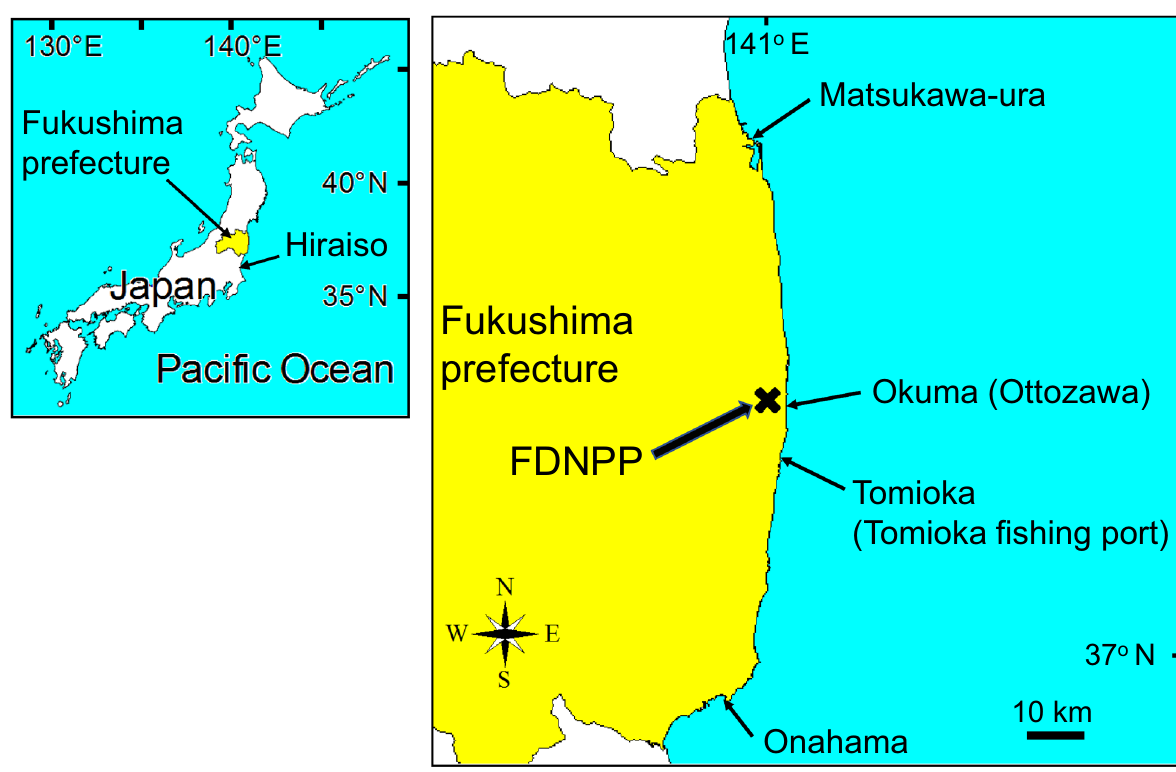
Figure 1. Sampling sites of the rock shell ( Thais clavigera and Thais bronni ) between April 2017 and May 2019. Two sites were near the Fukushima Daiichi Nuclear Power Plant (FDNPP) in Fukushima prefecture: Ottozawa, Okuma town, and Tomioka fishing port, Tomioka town are approximately 1 km and 10 km south of the FDNPP, respectively. The reference site, Hiraiso, Hitachi-naka city, Ibaraki prefecture, is approximately 120 km south of the FDNPP. Water temperature was observed at Onahama, Iwaki city, and at Matsukawa-ura, Soma city, by the Fukushima Prefectural Research Institute of Fisheries Resources. *The maps used in this figure are